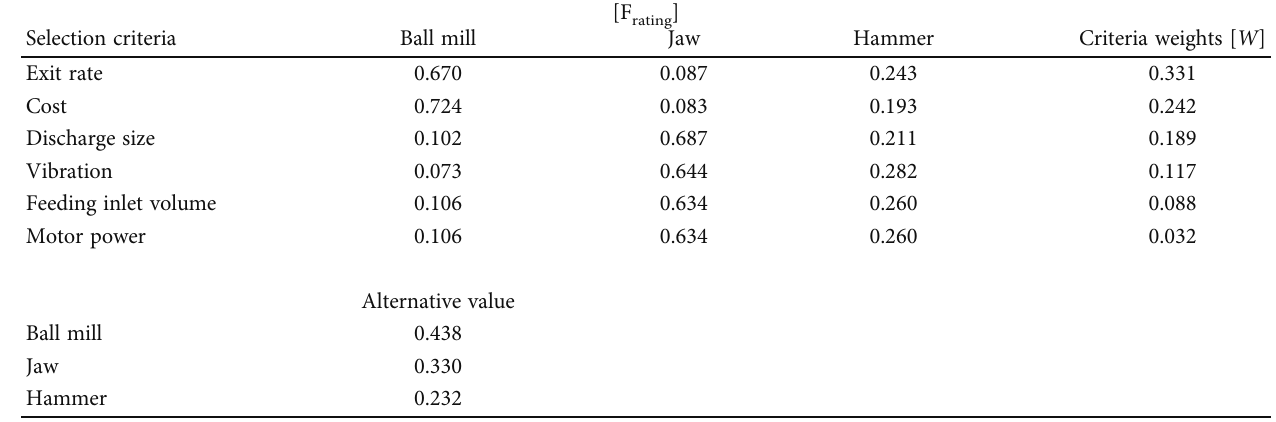
Table 6: Final rating matrix.